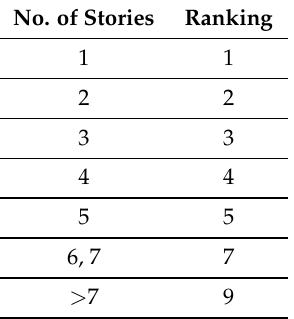
Table 9. ‘No. of stories’ rankings considered in MCDM methods.